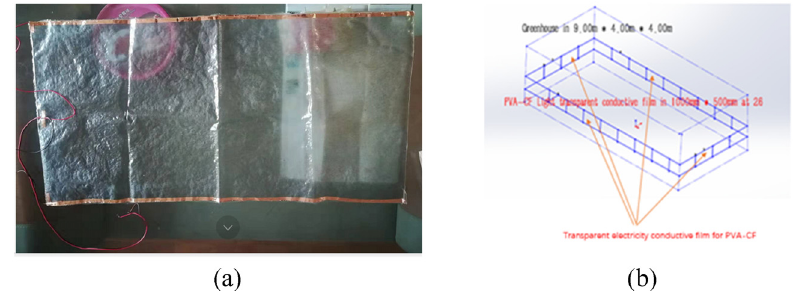
Figure 6: PVA - CF light transparent conductive fi lm be installed on the greenhouse wall: ( a ) PVA - CF transparent conductive fi lm; ( b ) installation of 26 sheets of PVA - CF to the custom - built agricultural